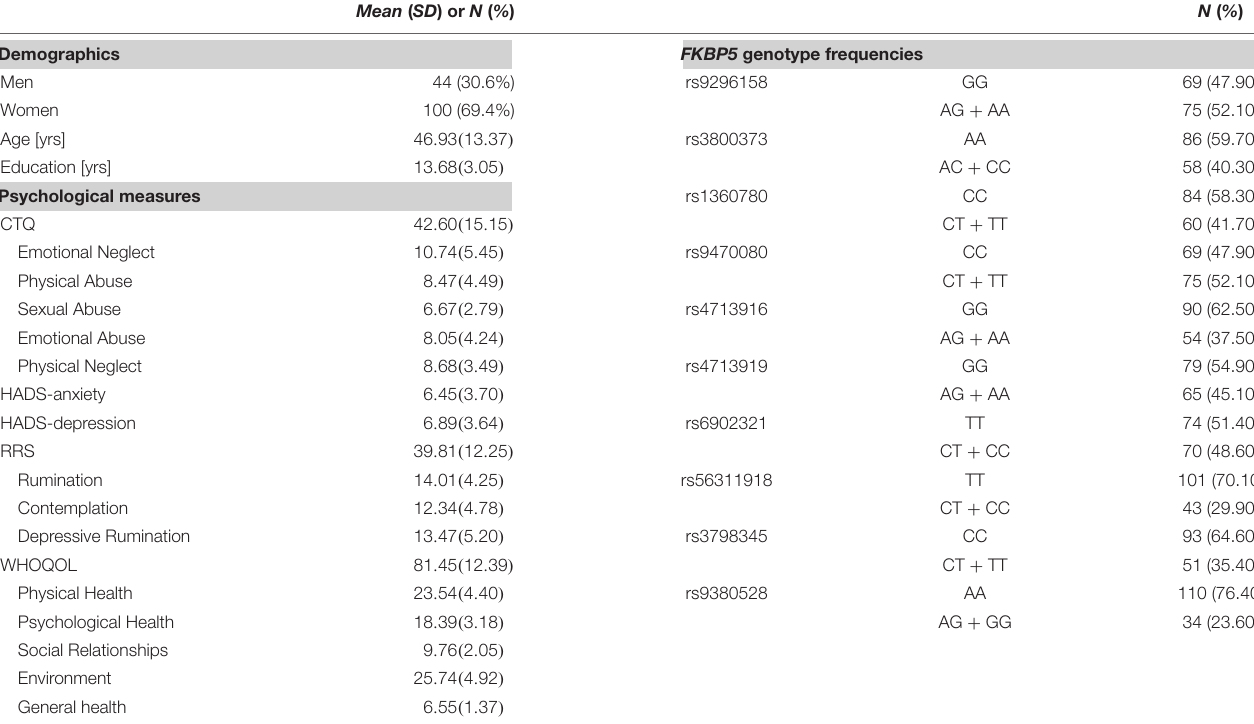
TABLE 1 | Demographics, psychological measures, and FKBP5 variants of participants ( N =